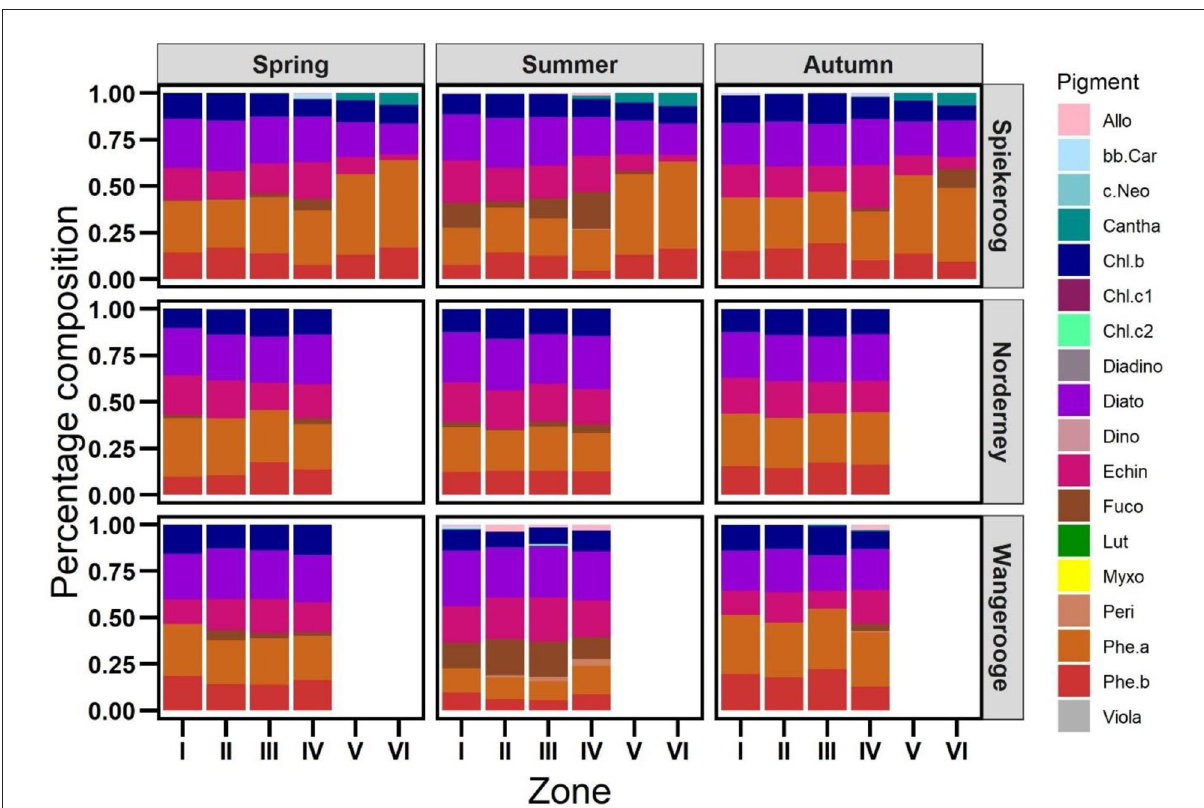
FIGURE6 Seasonal pigment:Chl-a biomass ratios (expressed as percentage) calculated for 18 pigments (based on Thrane et al., 2015) from samples sampled from Norderney, Spiekeroog, and Wangerooge (Pigment abbreviations: Allo, Alloxanthin; bb.Car, beta-carotene;